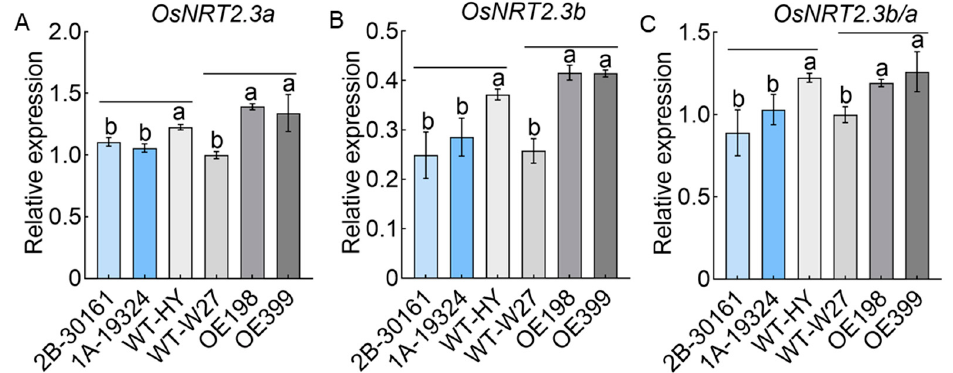
Figure 3. The expression of OsNRT2.3a and OsNRT2.3b in the T-DNA insertion mutant lines and OsTBP2.1 overexpression lines. The expression of OsNRT2.3a ( A ) and OsNRT2.3b ( B ) in the OE lines and ostbp2.1 lines. ( C ) The expression ratio of OsNRT2.3b to OsNRT2.3a in the OE lines and ostbp2.1 lines. Error bars: SE (n = 3). Significant differences between ostbp2.1 and WT-HY, OE, and WT-W27 are indicated by different letters ( p < 0.05).